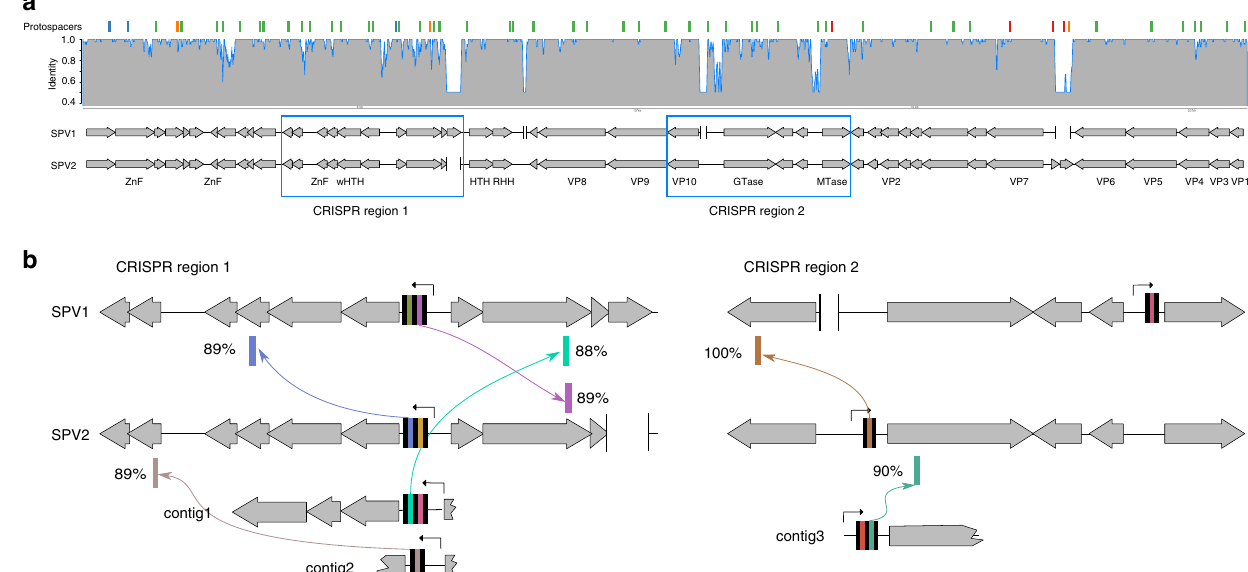
Fig. 3 Mini-CRISPR arrays in SPV1 and SPV2 genomes. a Comparison of the SPV1 and SPV2 genomes. Genes are represented with arrows following the direction of transcription. Deletions in one of the two genomes with respect to the other are indicated as gaps bordered with vertical lines. Gray histogram above the genome maps shows the identity calculated in 50 bp window from the SPV1-SPV2 nucleotide alignment. Locations of protospacers are showed as colored bars at the top of the fi gure. The regions zoomed-in in ( b ) are boxed. ZnF, zinc fi nger protein; (w)HTH, (winged) helix-turn-helix domain- containing protein; RHH, ribbon helix helix domain-containing protein; MTase, methyltransferase; GTase, glycosyltransferase; VP, virion protein. Source data are provided as a Source Data fi le. b Zoom-in on two regions of the SPV1 and SPV2 genomes carrying mini-CRISPR arrays (CRISPR region 1 and CRISPR region 2). Black bars represent CRISPR repeat. The predicted promoters in the leader sequences are indicated with broken arrows. Positions of hits of spacers from mini-CRISPR arrays carried by SPV-like viruses are shown with colored bars and arrows link the spacers and the corresponding protospacers. Identities between spacer and protospacers are indicated next to the protospacer bars. Three mini-CRISPR arrays found in the virome data are shown below the corresponding regions of alignment and labeled as contigs 1 to 3